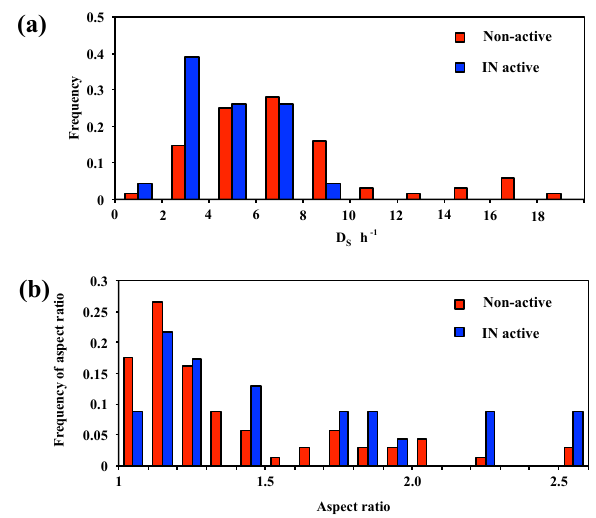
Figure 4. Frequency distributions of D S /h (a) and aspect ratio (b) for non-active and IN active particles from AFM observation.